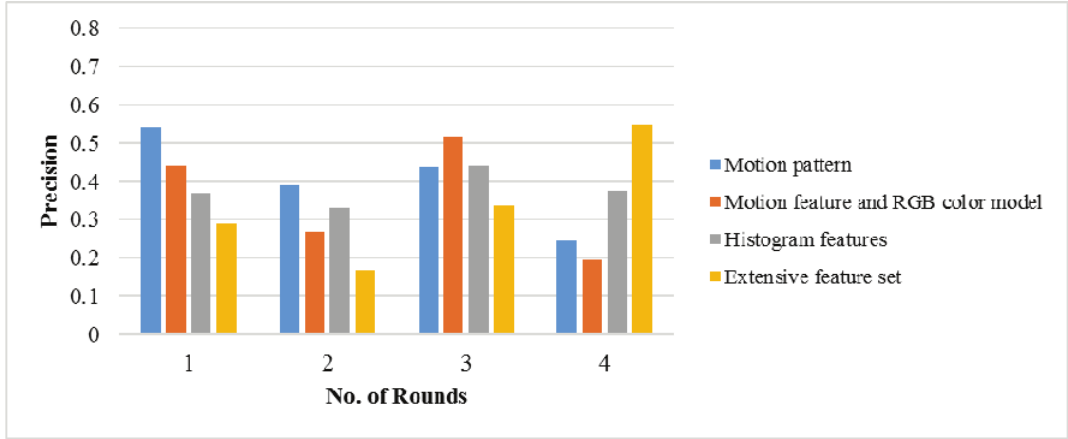
Fig. 7.Comparison plot of Mean (i) Precision, (ii) recall and (iii) F-score values for different rounds of retrieval obtained by the proposed CBVR system and other existing